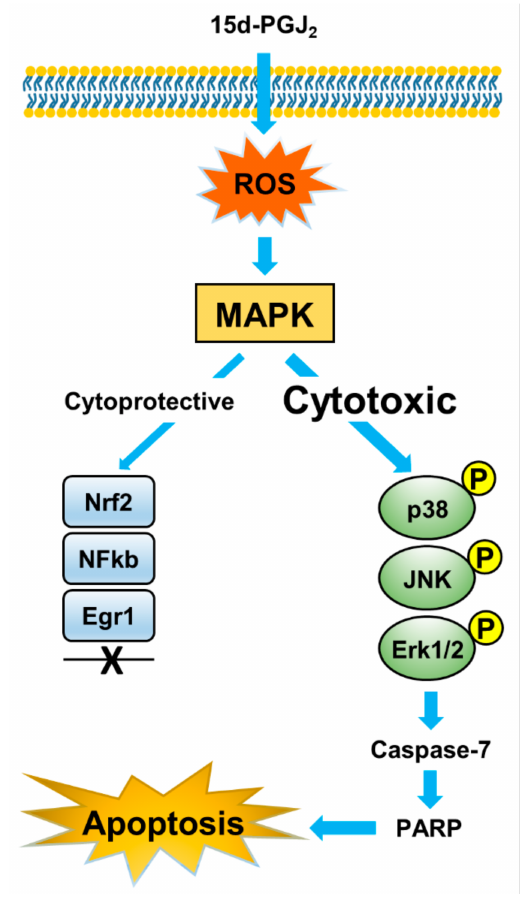
Figure 6. Model depicting the regulation of 15d-PGJ 2 -based apoptosis in OS cells. 15d-PGJ 2 in- duces intracellular ROS production, thus activating MAPK-dependent apoptosis. Cytoprotective mechanism are transiently induced by 15d-PGJ 2 ; however, they are quickly overwhelmed by apopto- sis